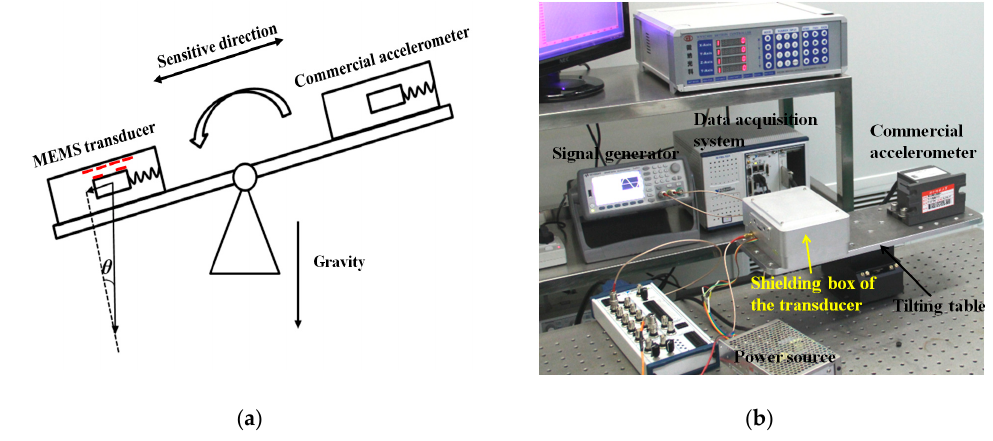
Figure 6. Calibration system. ( a ) Principle of the sensitivity calibration system using a tilting table; ( b ) Setup of the system. The capacitive transducer was set inside the shielding box.